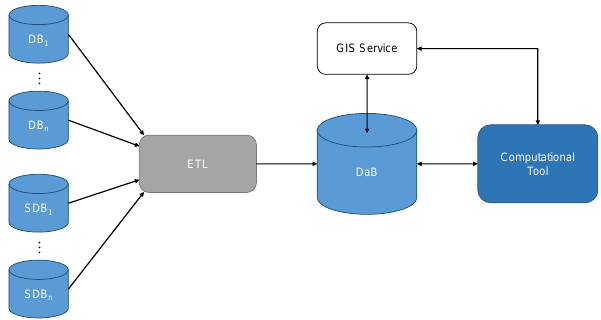
Figure 4. Database construction flow.